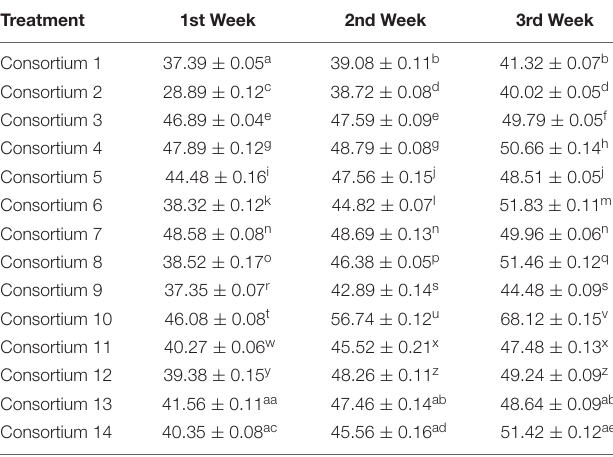
TABLE 3 | Petroleum hydrocarbon degradation by different consortia in different time